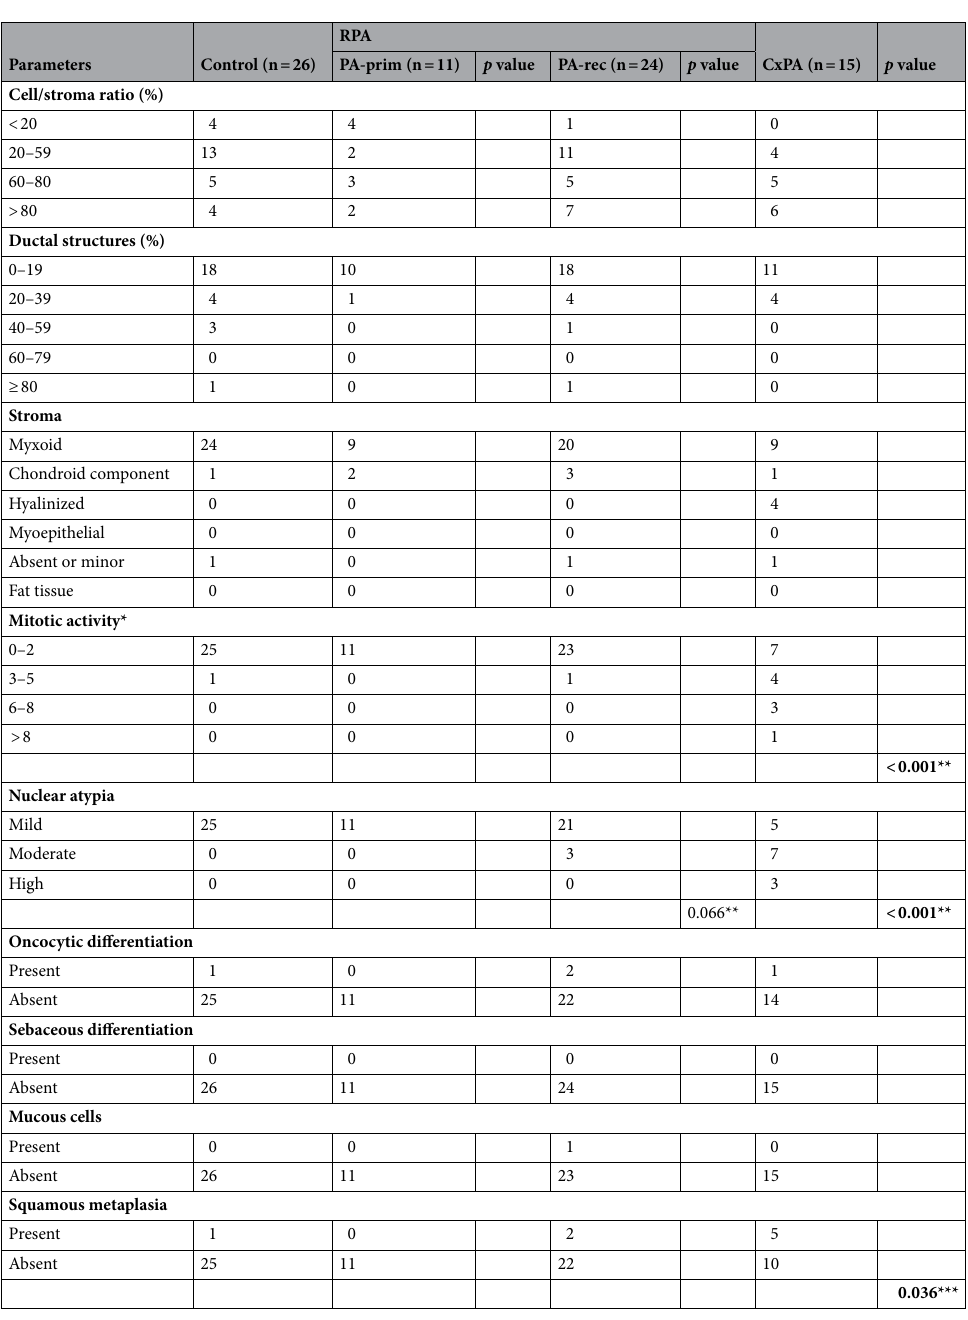
Table 4. Histological parameters and comparison with the control group. *Consecutive 10 HPF (high power fields). **Mann–Whitney U, bolded p values are statistically significant ( p < 0.05). ***Pearson Chi-Squared, bolded p values are statistically significant ( p < 0.05). RPA = Patients with recurrent pleomorphic adenoma. CxPA = Patients with carcinoma ex pleomorphic adenoma. PA-prim = Primary tumors of RPA patients. PA-rec = Recurrent tumors of RPA